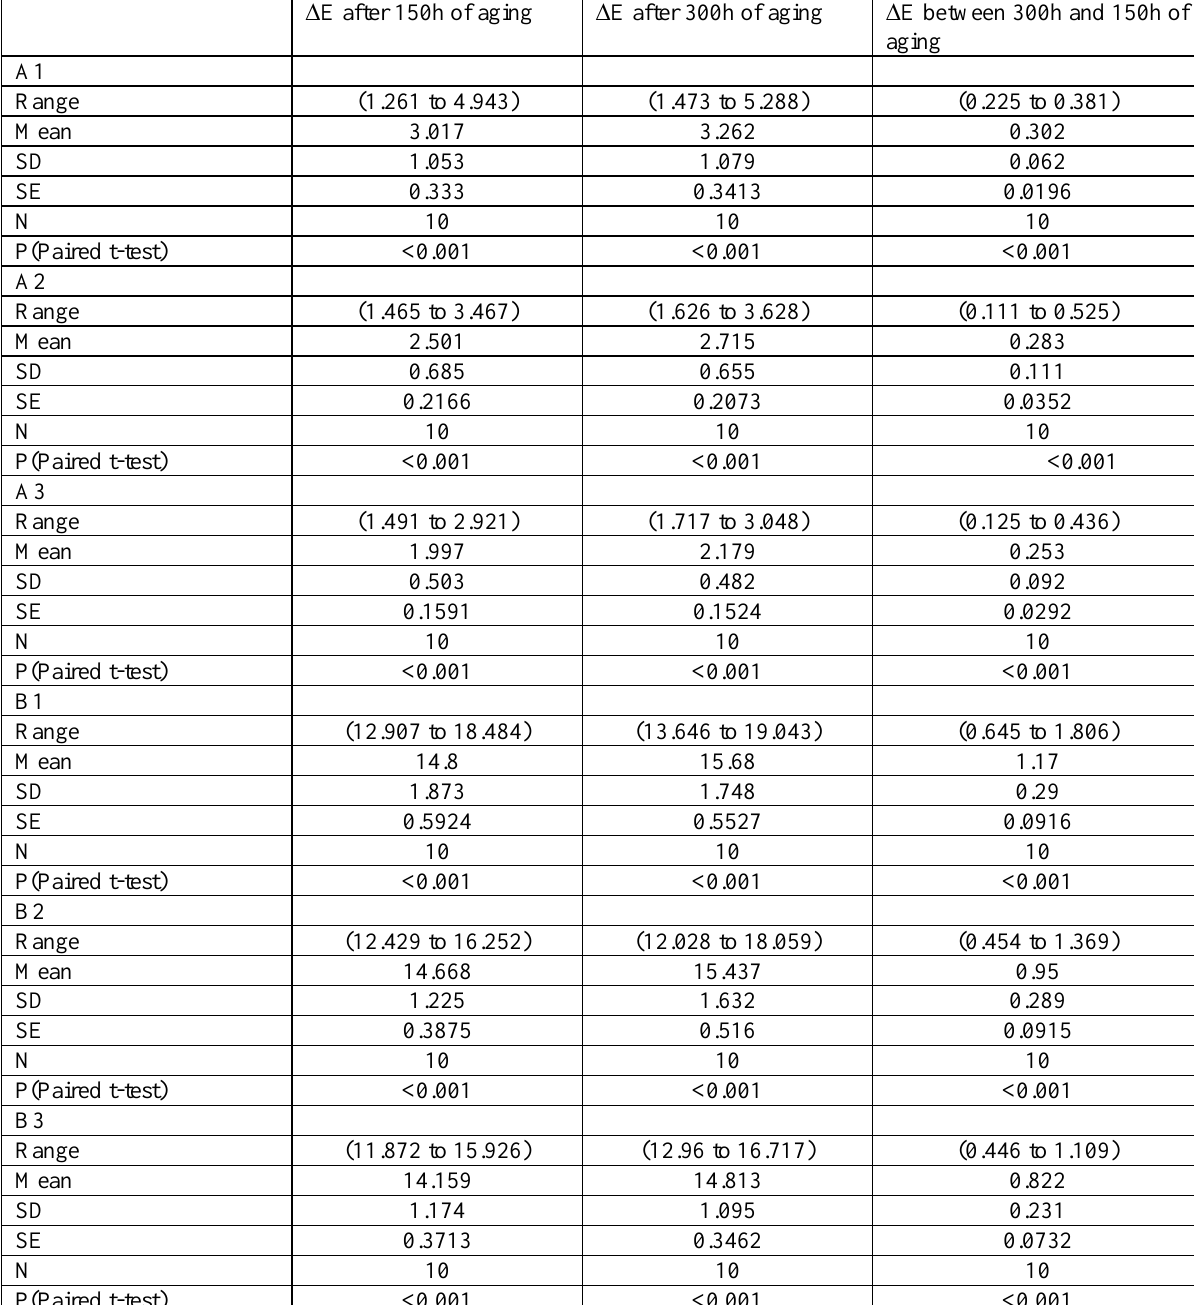
Table 1: Range, Mean, standard deviation, standard error and P (Paired t-test) of color change